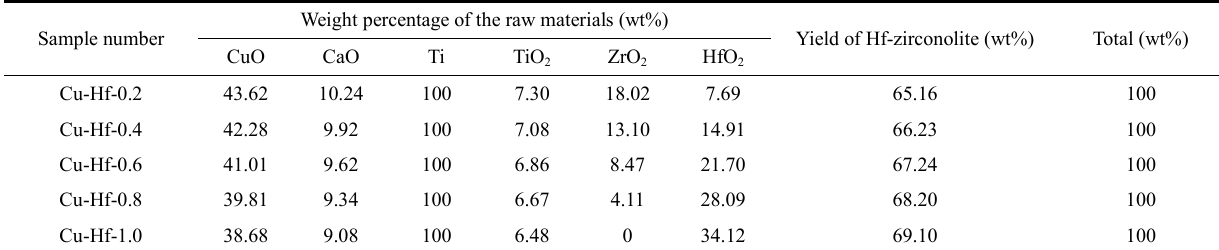
Table 1 Weight percentage of raw reactants for the Hf-doped